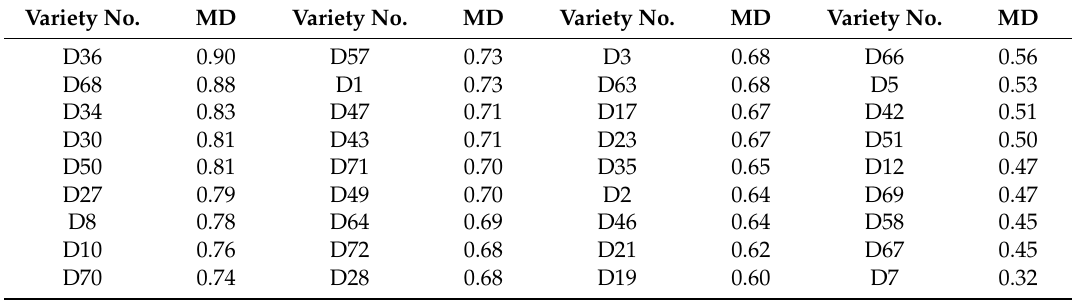
The data were collected after 30 days of transplanting. Values are means ± SD, n = 3. Table 3. Salt tolerance index of 36 rice varieties with respect to membership degree in the 2:1 potting mixture (NS:SAS = 2:1). Variety No. MD Variety No. Variety No. Variety